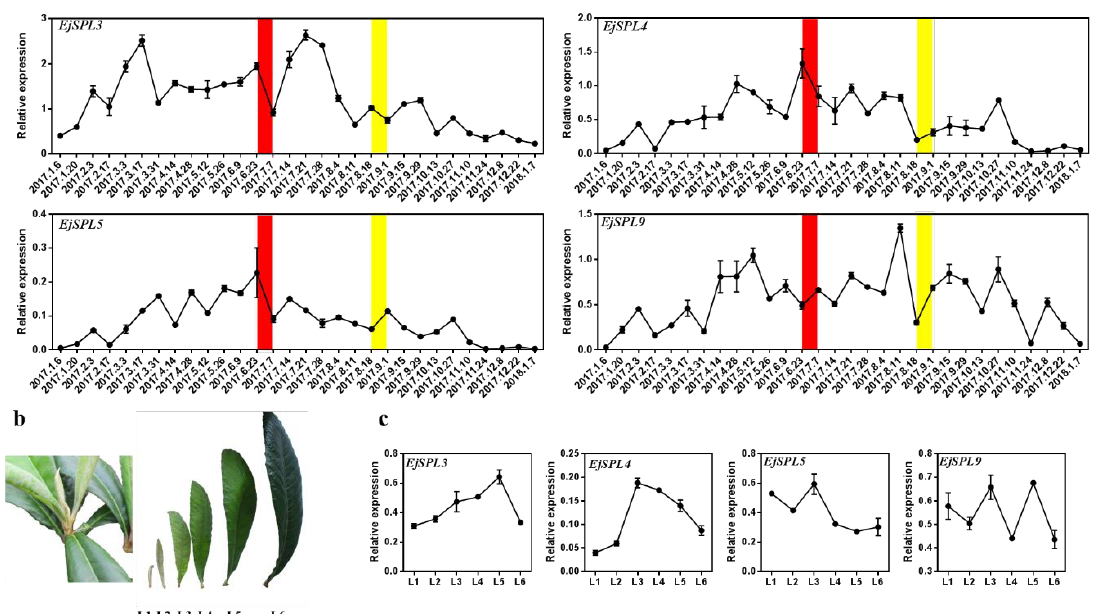
Figure 4. Relative expression levels of SPL genes in the leaves of “JFZ”. ( a ) Expression patterns of SPL genes in the mature leaves at different periods. ( b ) The leaves at different developmental stages. ( c ) Expression patterns of SPL genes in ( b ). Red box and yellow box indicate the beginning of flower bud differentiation and the obvious inflorescence that can be seen, respectively. Ejβ-actin as an internal control. Error bars indicating SE from three biological replicates.